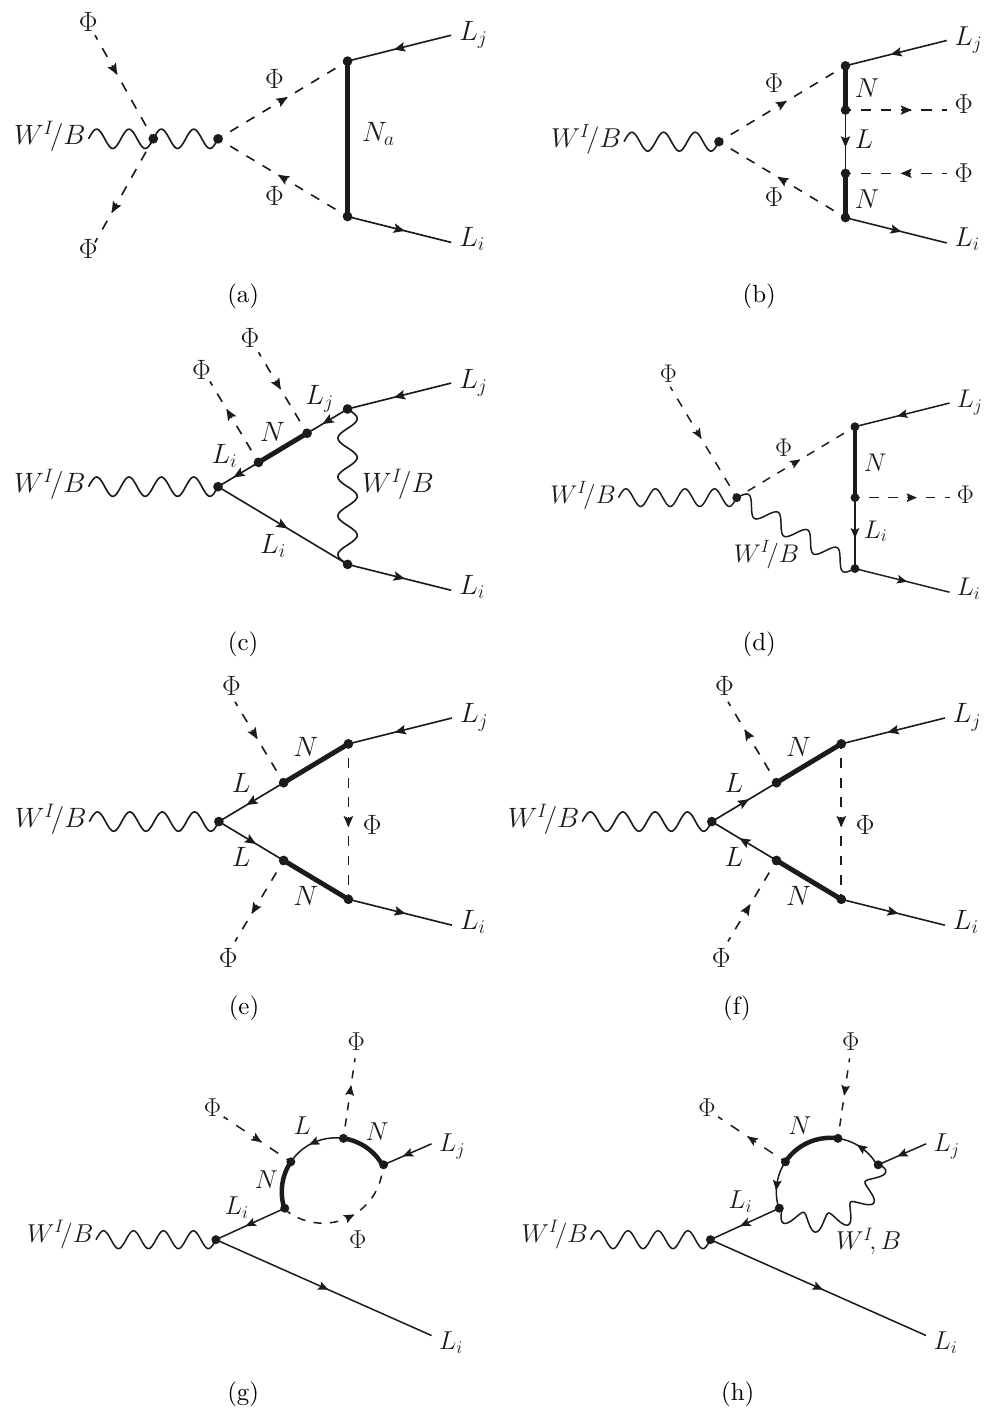
and O (3) (see figure 3(b)) or, ϕ‘ ϕ‘